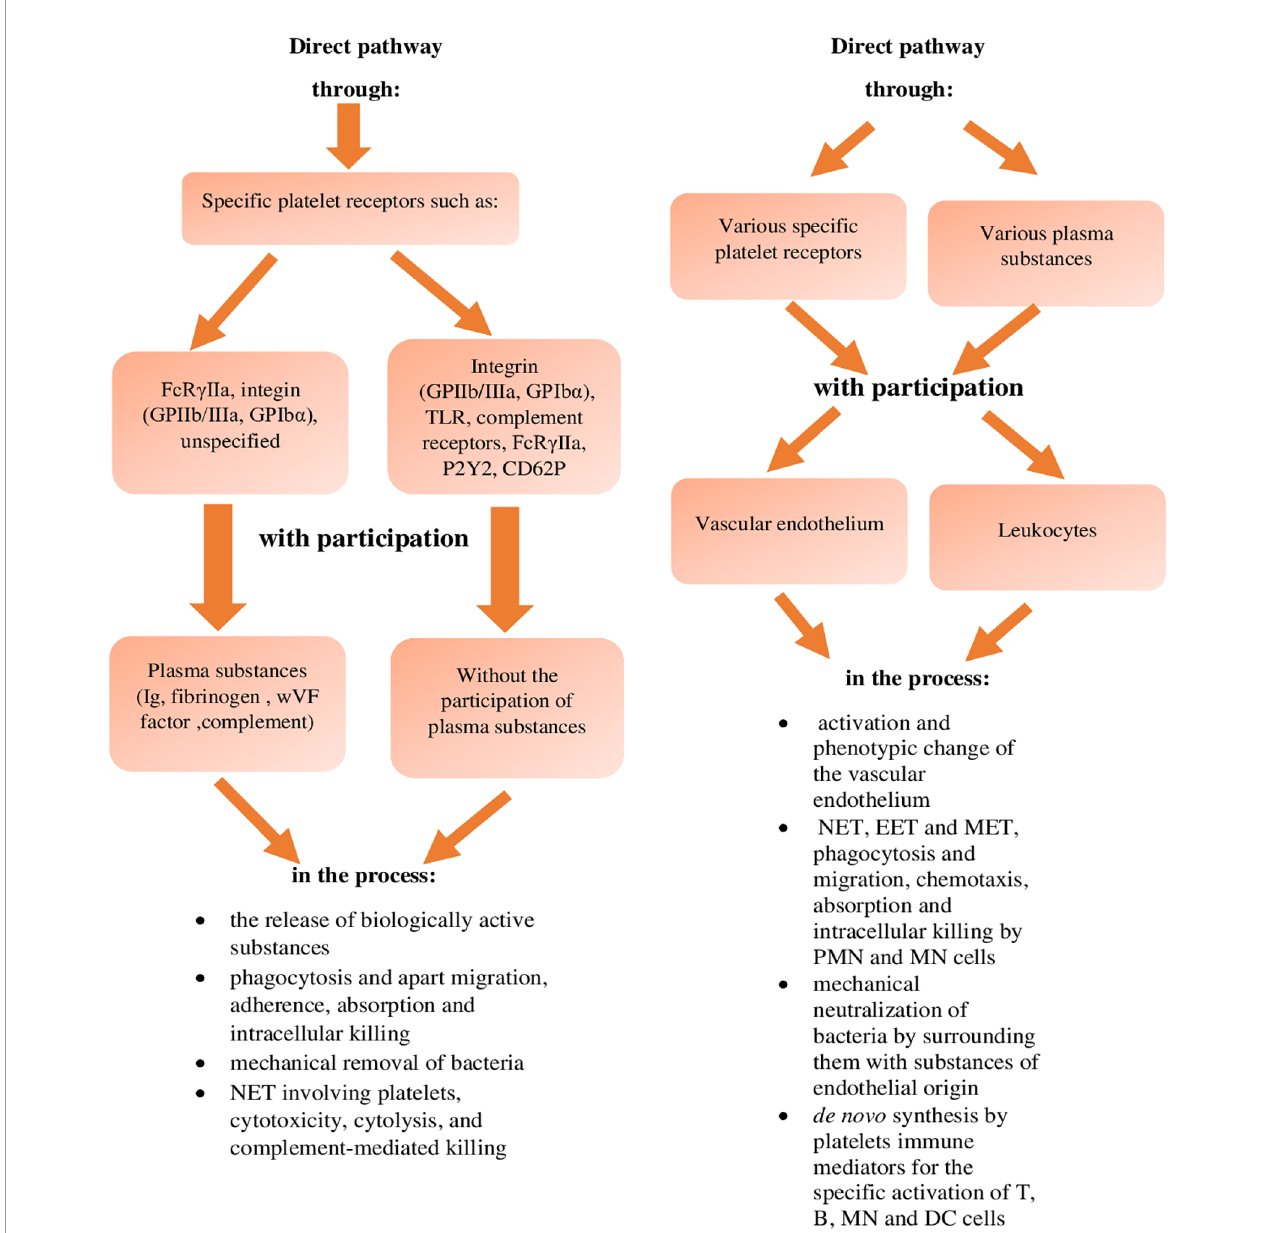
FIGURE 1 | Effect of inactivating platelets against bacteria (reference in the text). NET, Neutrophil Extracellular Traps; EET, Eosinophil Extracellular Traps; MET, Monocyte-drive Extracellular Traps; PMN, polymorphonuclear cells; MN, mononuclear cells; DC, dendritic